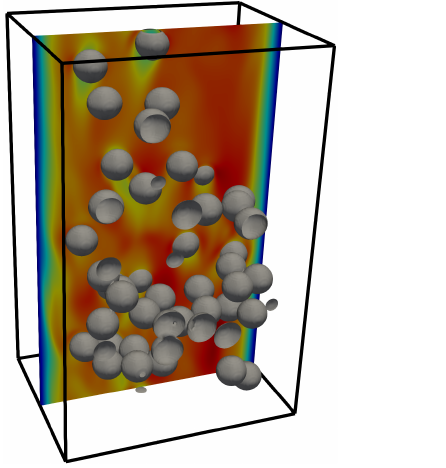
Figure 3. A straightforward way to investigate the bubble shapes occurring for the different setups is to visualize the isocontours corresponding to f = 0.5, i.e., the interface between gas and liquid phase. Snapshots for the bubbly-flow cases with a Newtonian fluid in the continuous phase are shown in Figure 15. Since there are hardly any visible differences for the non-Newtonian fluids, the respective plots are omitted. The isosurfaces confirm the prediction of the Grace diagram. As expected, the bubbles are quasi-spherical for Eo = 0.3125. However, when Eo is increased to 3.75, the bubbles are wobbling and assume an ellipsoidal shape.